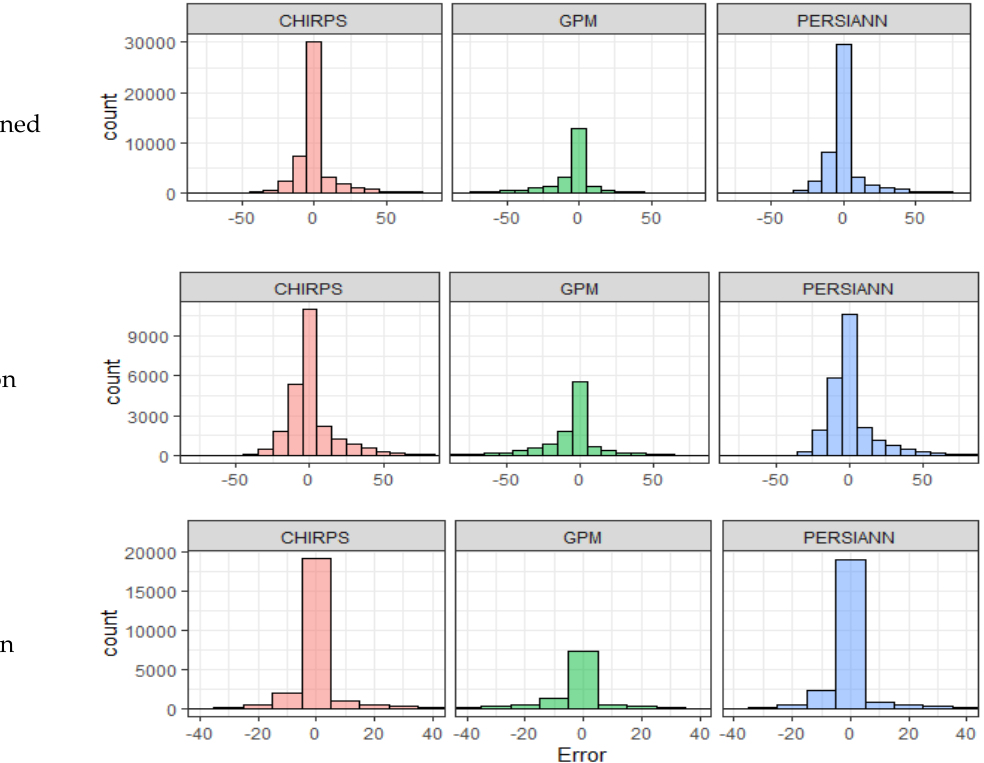
Figure 7. Error histograms of three satellite rainfall products.